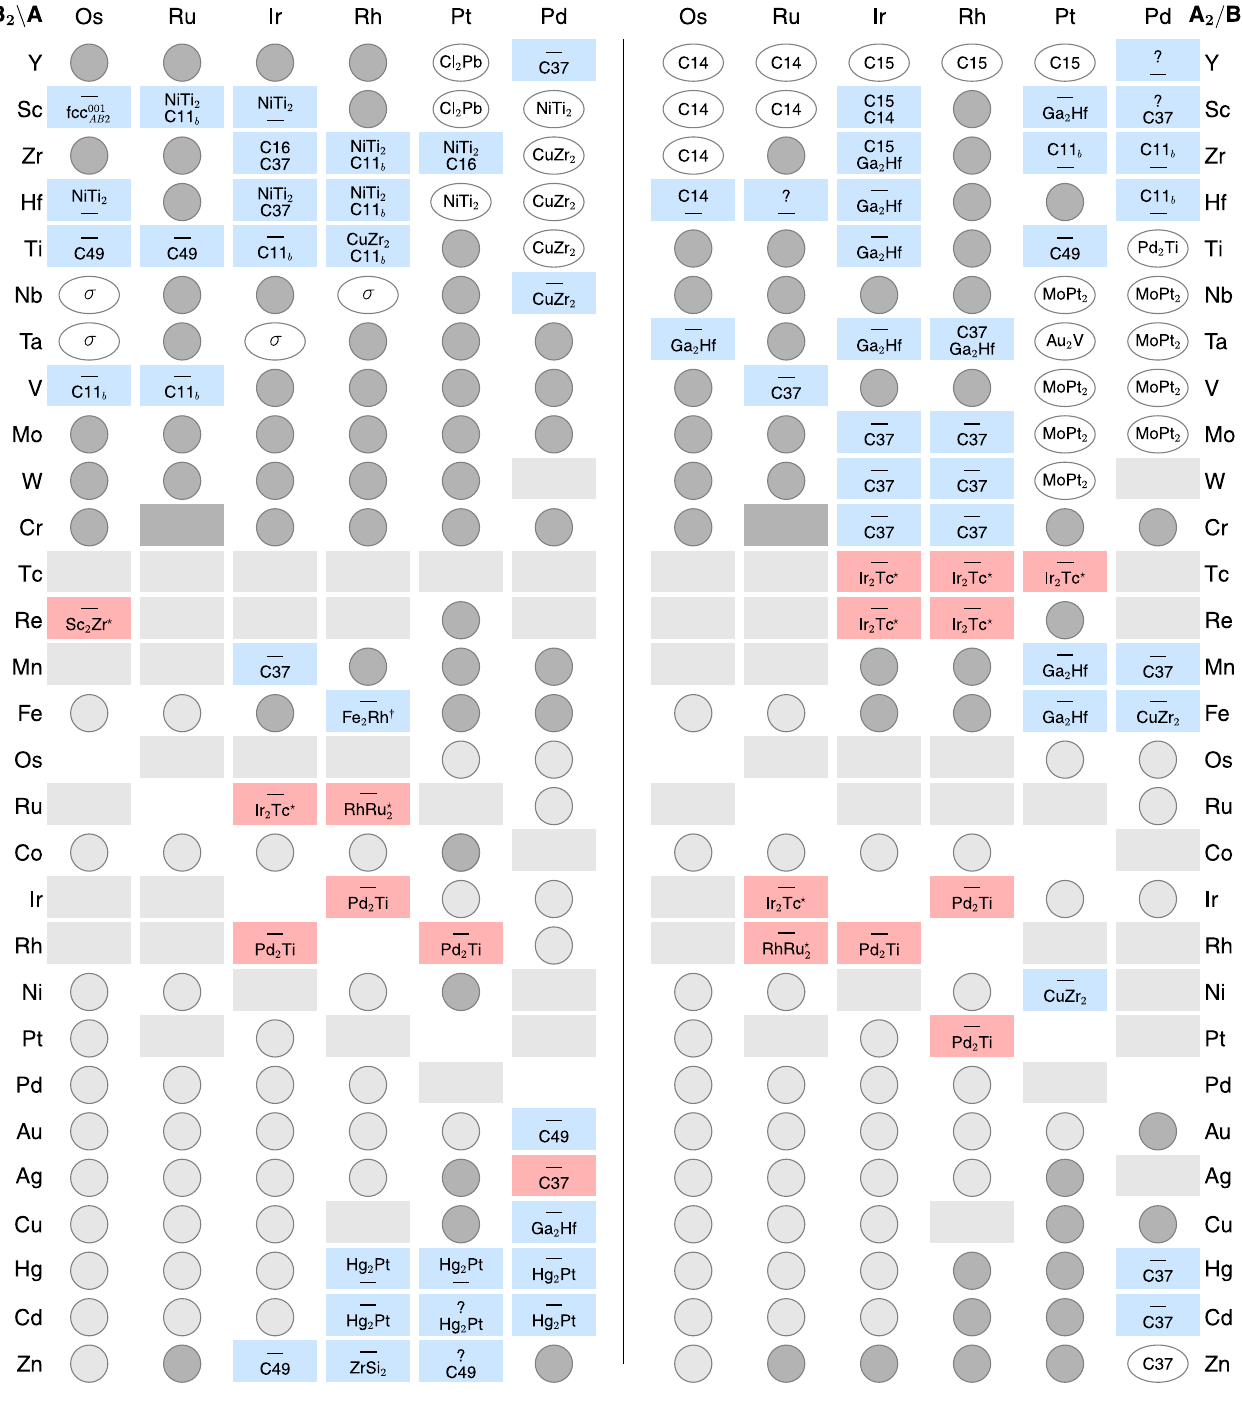
FIG. 3. A Pettifor-type structure map for 1:2 stoichiometry compounds in PGM binary systems. The symbols are as in Fig. 2, with the map stoichiometry changed, respectively, from 1:1 to 1:2 or 2:1